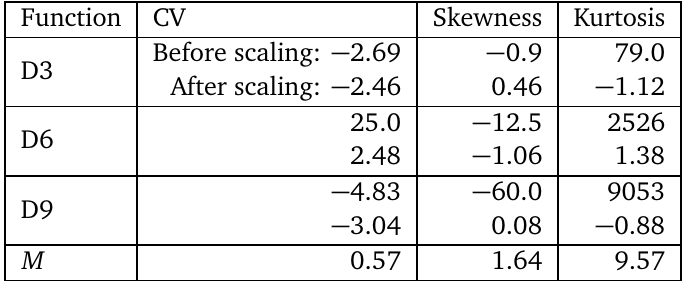
Table 1: Data statistics before and after scaling for the D3, D6, D9, and M